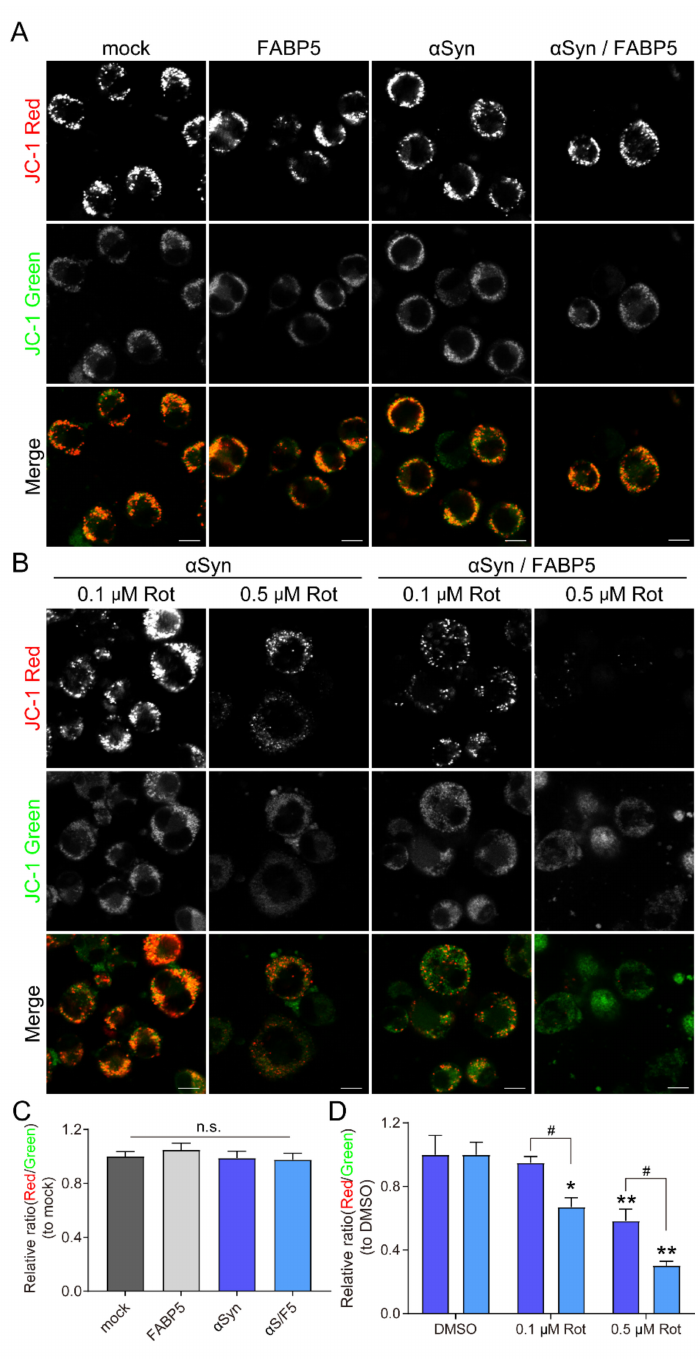
Figure 4. FABP5 involvement in rotenone-induced reduction of mitochondrial activity. ( A , B ) Repre- sentative images of JC-1-stained Neuro-2A cells. The decrease in the ratio of red to green fluorescence of JC-1 dye was indicated by a reduction in mitochondrial membrane potential. ( A ) Cells were transfected with pcDNA 3.1, FABP5, α Syn, and α S/F5 , respectively, then exposed to DMSO. ( B ) α Syn and α S/F5 transfected cells were exposed to 0.1 or 0.5 µ M rotenone. ( C , D ) Graphs demonstrating the quantification of the ratio of JC-1 red to green fluorescent intensity in Neuro-2A cells. Results are presented as means ± SEM (n > 300 cells in C and n = 5 wells in D from parallel cell experiments). * p < 0.05, ** p < 0.01, vs. DMSO-treated groups; # p < 0.05, vs. α Syn -transfected groups. n.s., not statistically significant. Scale bars: 10 µ